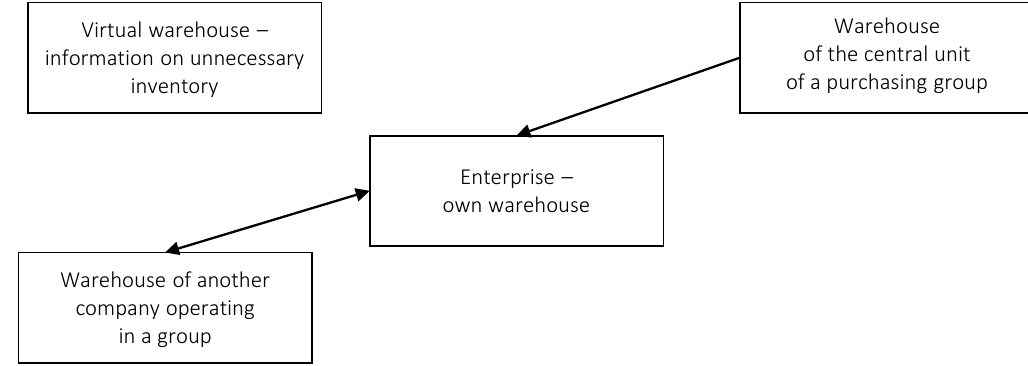
Figure 1. Functioning of warehouses in a commercial group purchasing